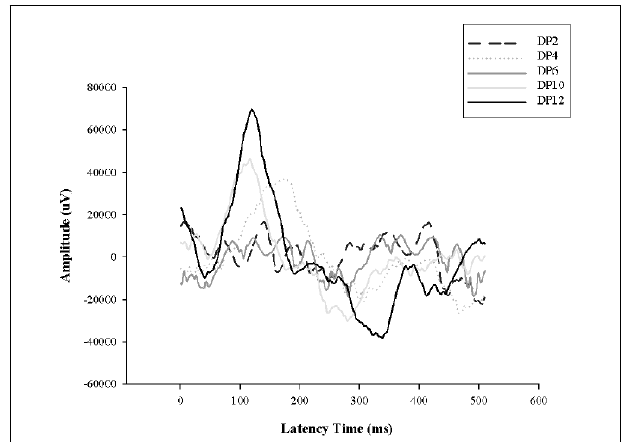
FIGURE 6 | Electroretinogram (ERG) analysis in animals exposed to dark period. Animals exposed for 8 days of constant light with dark periods of 2, 4, 6, 10 and 12 h per day during subjective night (DP 2–8); DD, constant dark. DP, dark